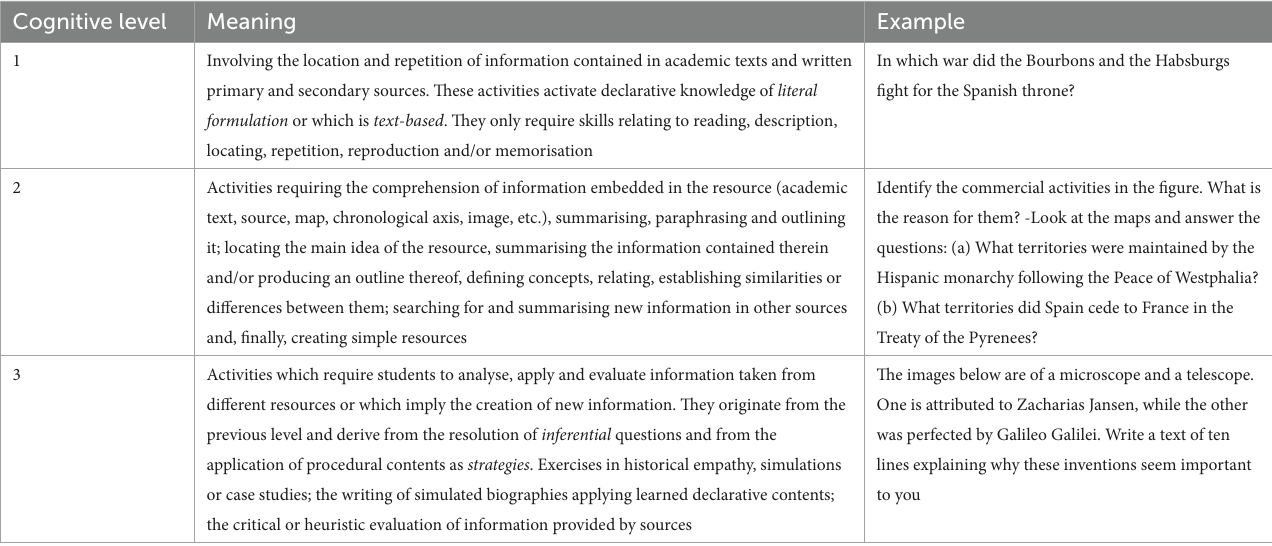
TABLE 4 Meaning and examples of the cognitive level required of students in the activities contained in the textbooks. Cognitive level Meaning